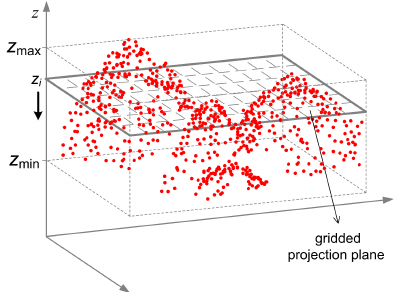
Figure 4. Downward projection of the first pulse data points onto an elevation-variable horizontal gridded